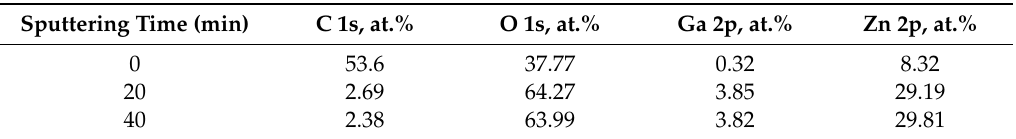
Table 2. Atomic percentage concentration of the elements in ZGO film, deposited at the sputtering voltage 1.1 kV after 0, 20, and 40 min of etching.